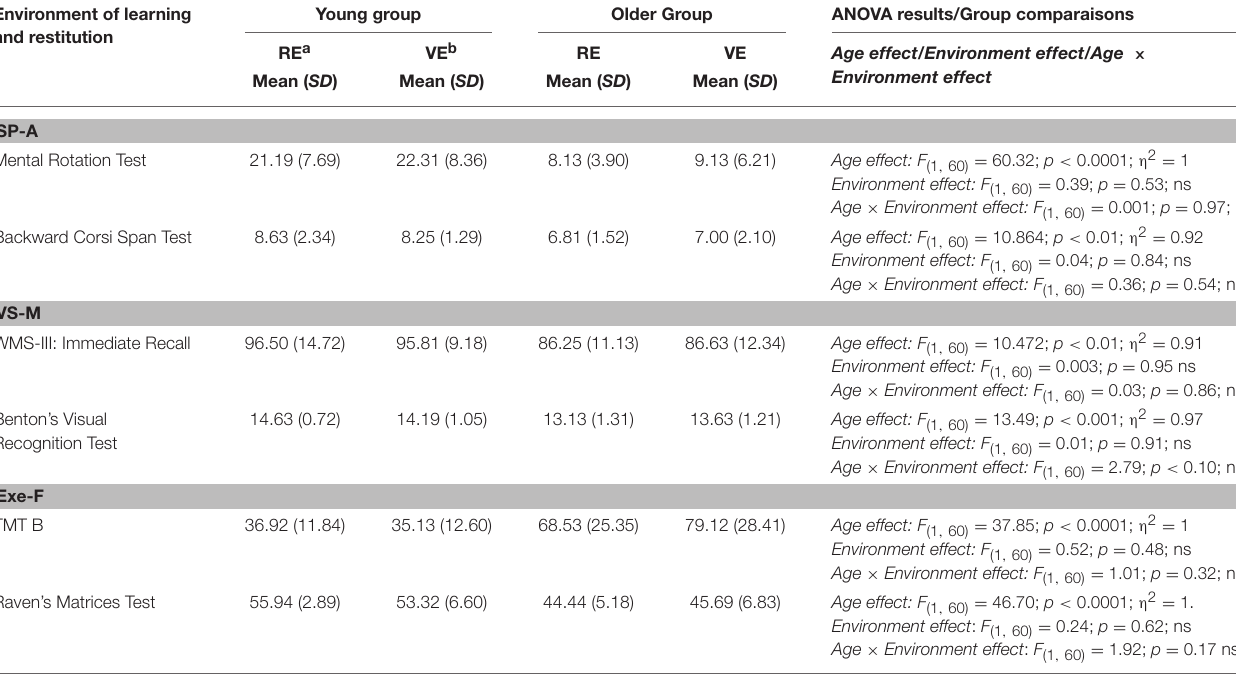
TABLE 2 | Scores on the neuropsychological assessments: Visuospatial abilities (SP-A), Visuospatial memory (VS-M) and executive functioning (Exe-F). Environment of learning and